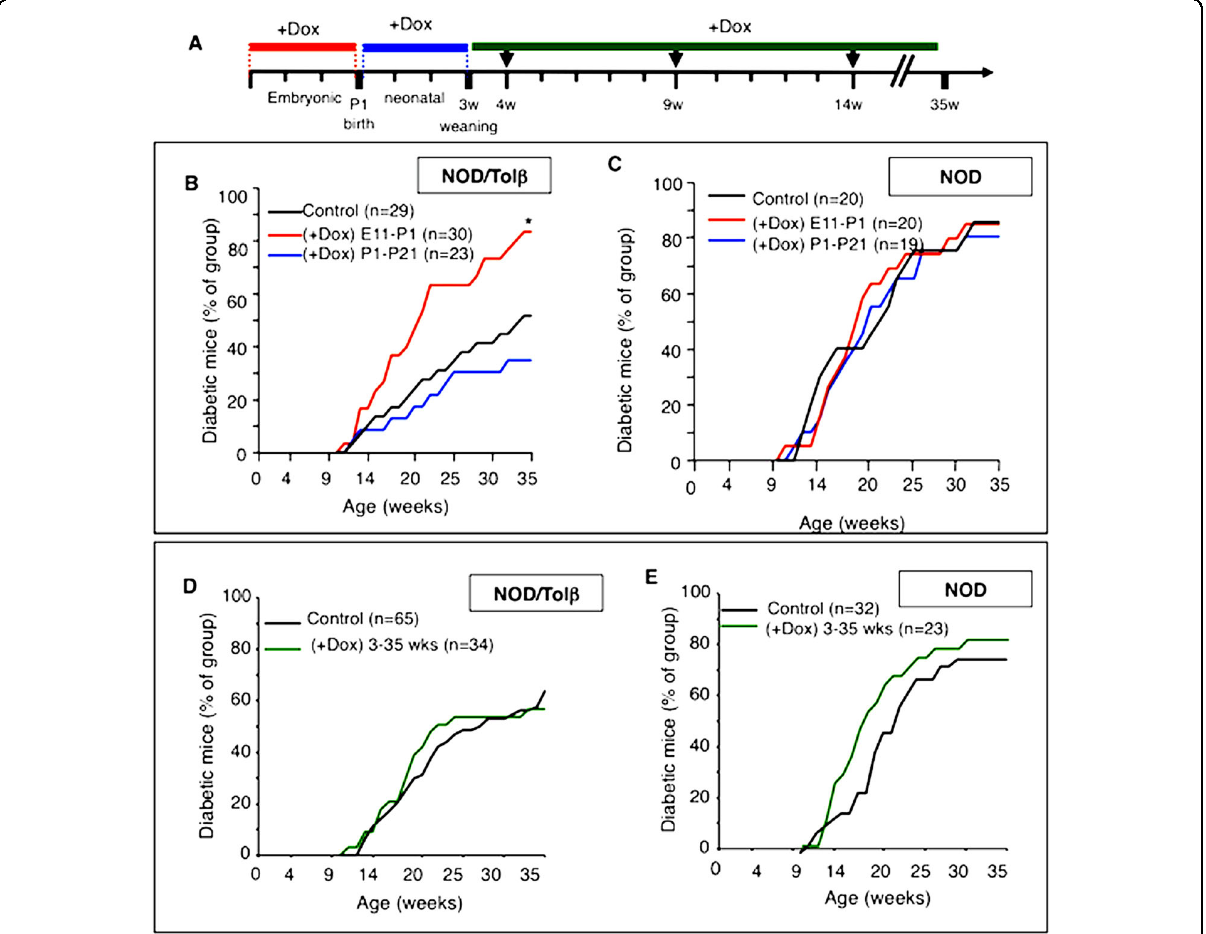
Fig. 3 Effects of selective and conditional expression of Δ NI κ B α in insulin-producing cells during embryonic, neonatal, or adult periods on diabetes incidence in NOD/ToI β as compared to the parental NOD/LtJ female mice. A Experimental design: NOD/ToI β or NOD/LtJ female mice were exposed to Dox (0.2 mg/ml) during the embryonic period until birth (E11 – P1: red line), during the neonatal period from birth to weaning (P1 – P21: blue line) or after weaning (3 – 35 weeks) up to 35 weeks (green line). Diabetes incidence was monitored once a week until 35 weeks. B Percentage of hyperglycemic NOD/ToI β mice in untreated (control, black line, n = 29) or Dox-treated animals during the embryonic period until birth (red line, n = 30); from birth until weaning (blue line n = 23) or D between 3 and 35 weeks (green line, n = 34). * P < 0.008 vs control. C , E Percentage of hyperglycemic mice in the parental NOD/LtJ female mice similarly treated as in B and D . C NOD/LtJ mice untreated (control, black lane n = 20); or Dox-treated animals during the embryonic period until birth (red line, n = 20); from birth until weaning (blue line n = 19). E Diabetes incidence in untreated (control; black line, n = 65) and Dox-treated animals from 3 weeks onward until the end of the follow-up at 35 weeks (green line, n =